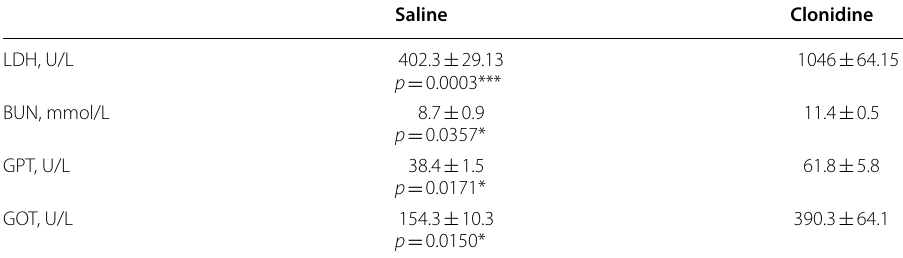
Table 1 Hypotension-induced organ